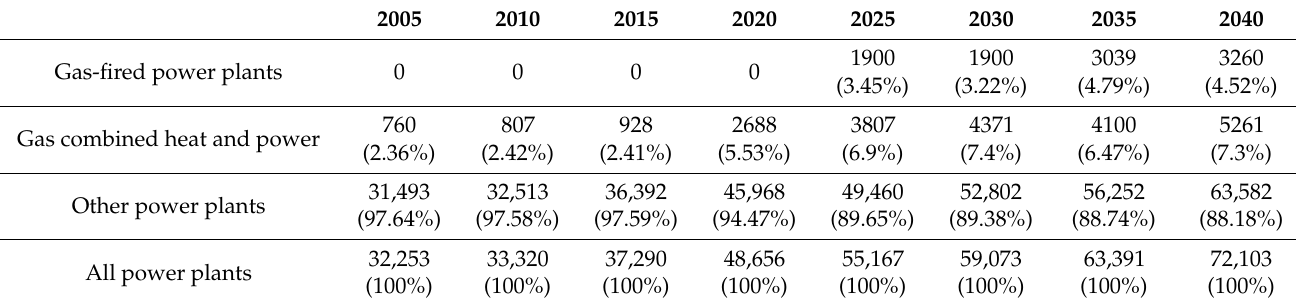
Table 4. The forecast share of natural gas in electricity generation,